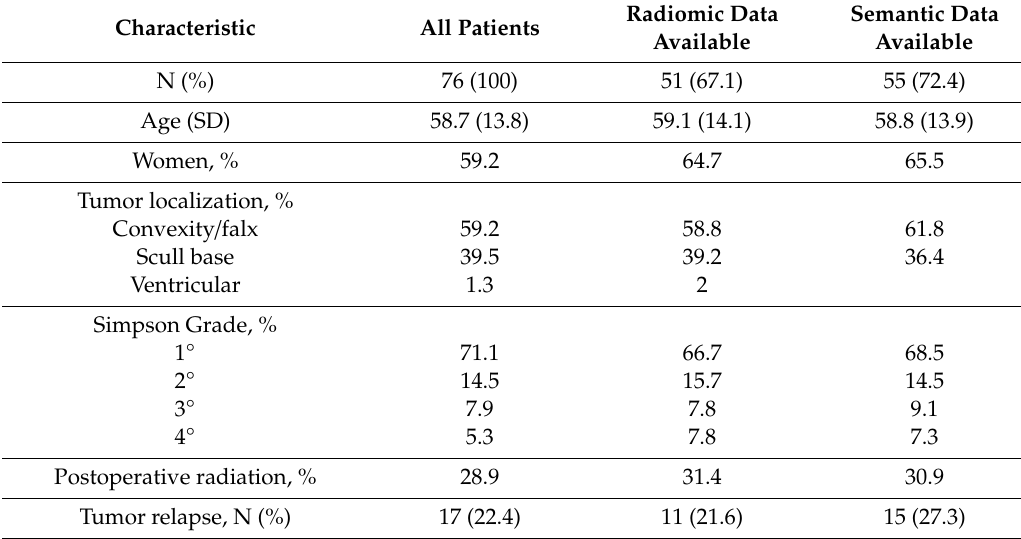
Table 1. Patient characteristics.